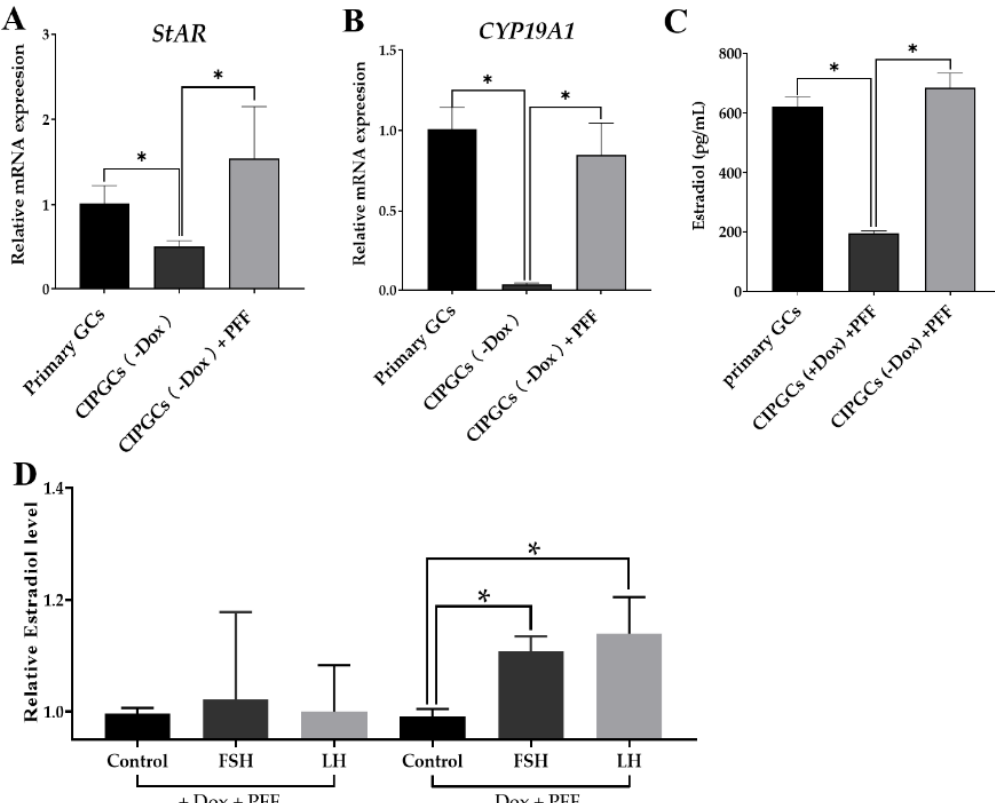
Figure 8. The function analysis of the CIPGCs. The mRNA expression of StAR ( A ) and CYP19A1 ( B ) by quantitative PCR after culturing for six days without Dox treatment in company with or without PFF when compared with primary GCs. ( C ) Determination of estradiol level among primary GCs, CIPGCs ( + Dox), and CIPGCs (–Dox). (D) The estradiol level in the CIPGCs (–Dox) with addition of FSH and LH. PFF, porcine follicular fluid. Data are represented as mean ± SEM of three independent experiment ( n = 3). * stands for significant difference between two groups ( P < 0.05).